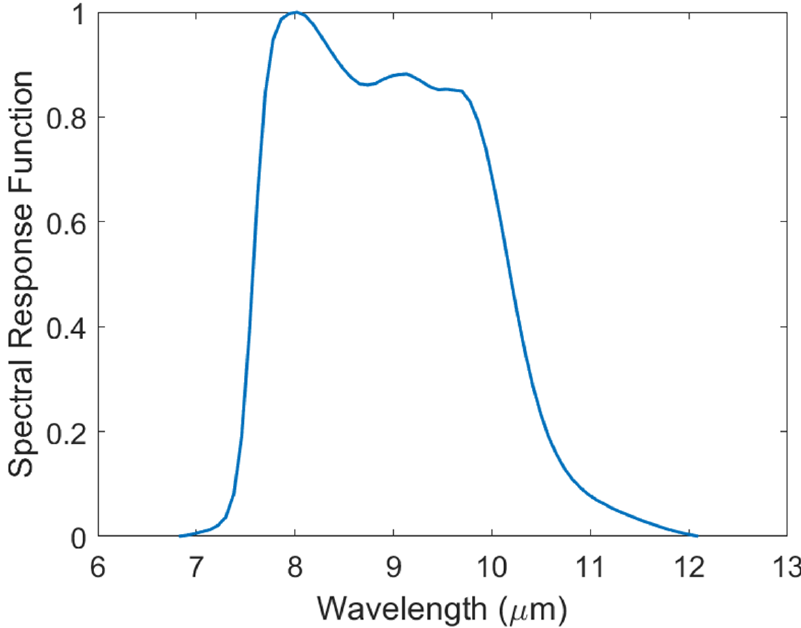
Figure 1. The spectral response function for the thermal infrared camera (sensor1 and sensor2).